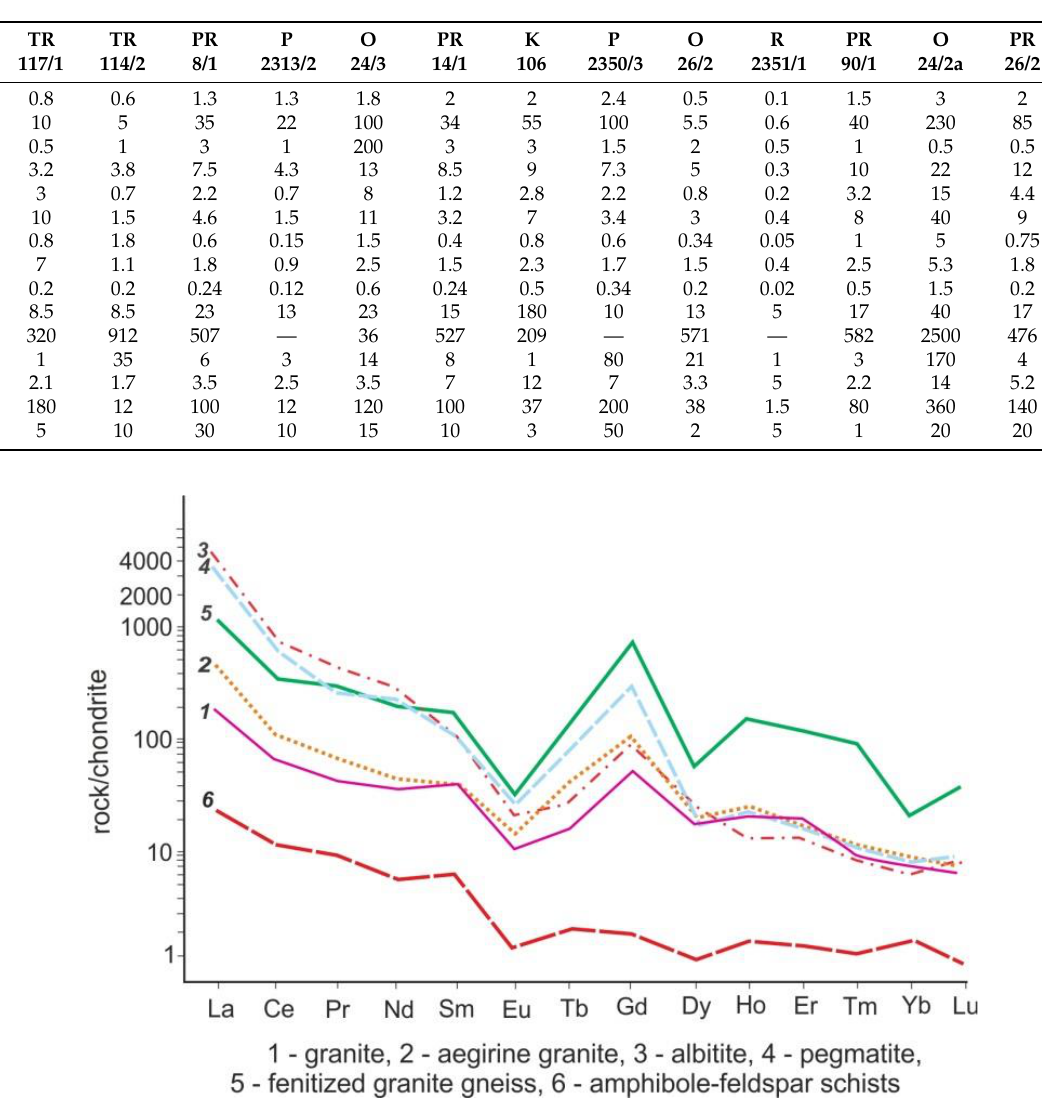
Figure 17. Chondrite-normalized [66] REE distribution patterns for the rocks of the Tommot ore field. Major ore bodies of the deposit are localized in fenitized albitites and pegmatites. Table 5 shows the distribution of REEs in them. It is easy to see that the principal ore elements are Ce and Y, and other metals are present in subordinate quantities. Thus, the deposit can be classed as a complex Y-Ce deposit. Table 5. Average composition of ores of the Tommot deposit (in wt%).